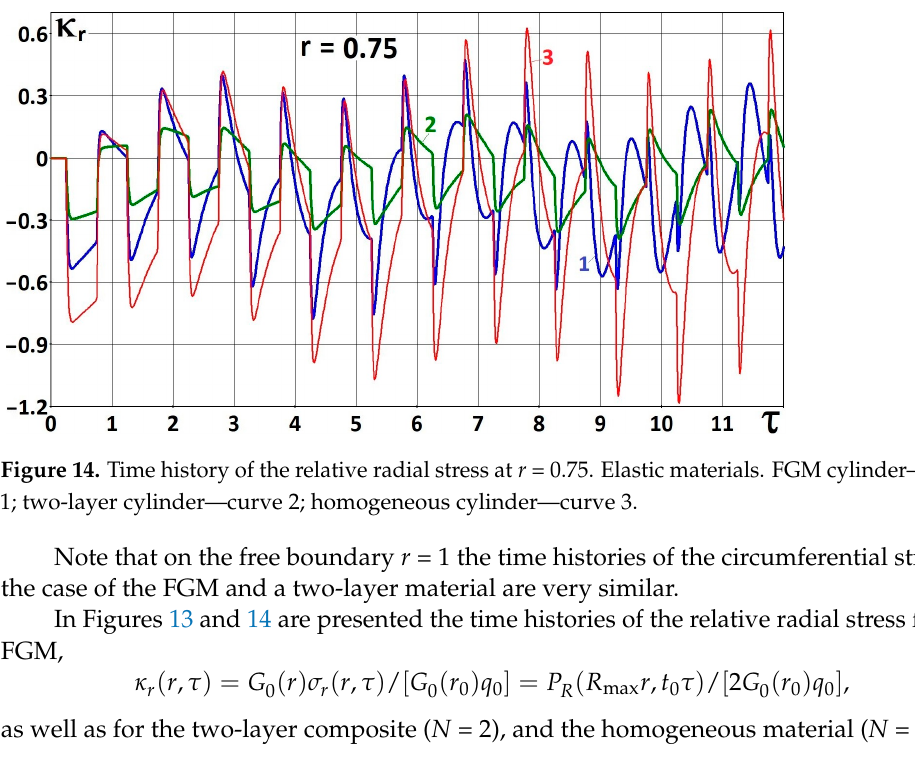
Figure 13. Time history of the relative radial stress at r = 0.75. Viscoelastic materials. FGM cylinder— curve 1; two-layer cylinder—curve 2; homogeneous cylinder—curve 3.